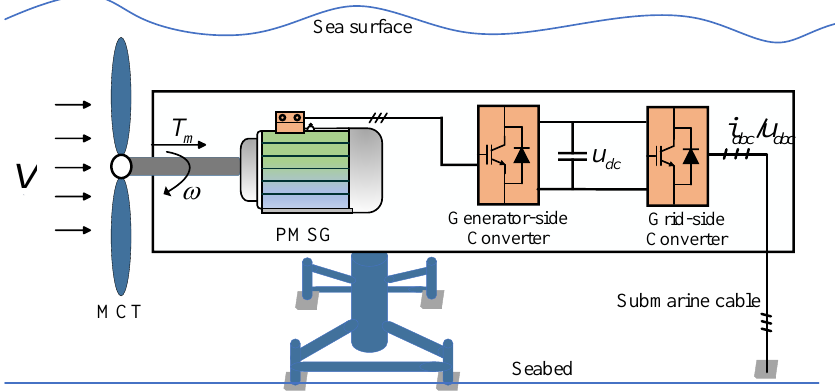
Figure 1. The general scheme for a (PMSG)-based marine current turbine (MCT) system.